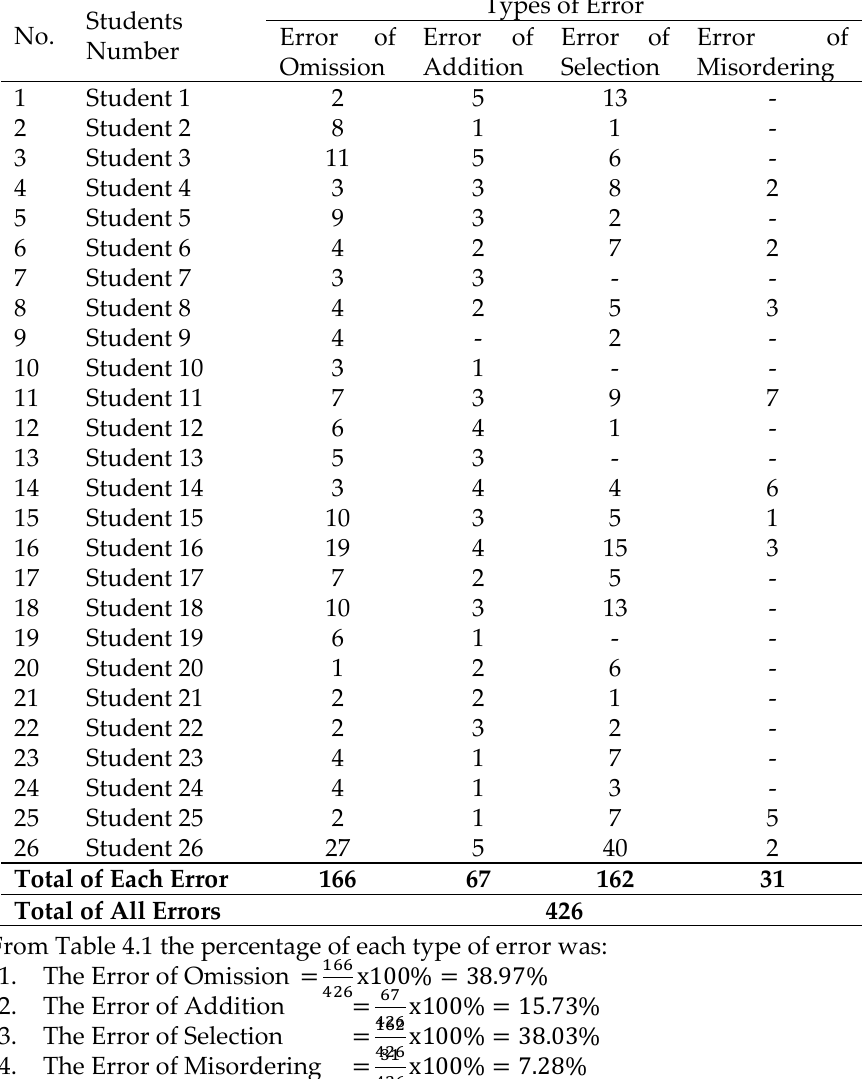
Table 4.1. The Recapitulation of the Student’s Error